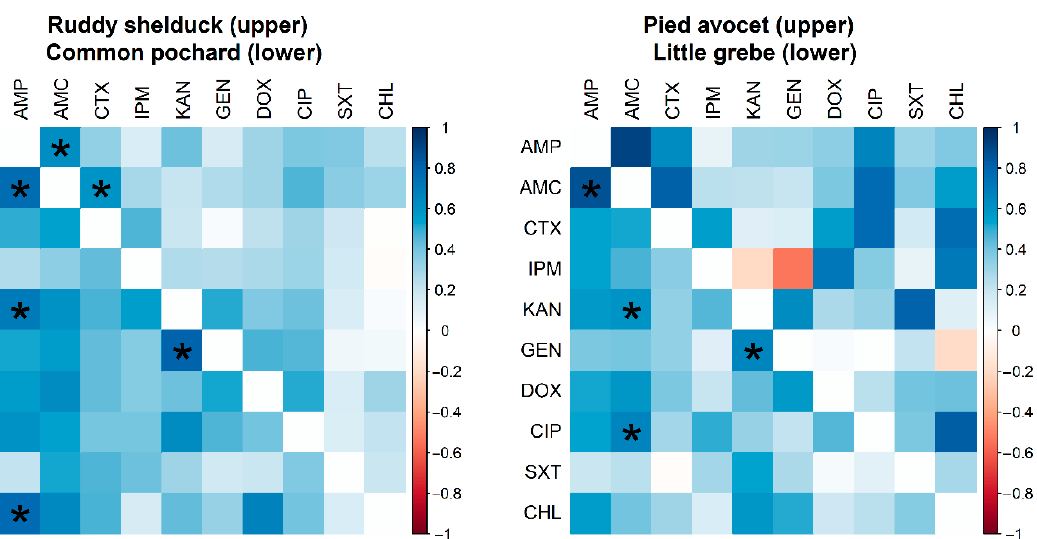
Figure 4. Box and whisker plot of multiple antibiotic resistance (MAR) index among Escherichia coli , Salmonella typhi- murium, and Staphylococcus spp. recovered from different species of migratory wild birds around the Al-Asfar Lake. 2.3. Virulence and Antimicrobial Resistance Genes Of the 90 E. coli isolates, only 9 (10%) and 5 (5.6%) isolates showed the presence of eaeA and stx2 virulence-associated genes, respectively. However, both eaeA and stx2 genes were identified in four (4.4%) isolates. None of the E. coli isolates carried the hlyA and stx1 virulence-associated genes. The frequency of virulence genes in E. coli isolates recovered from each migratory wild bird species is presented in Figure 5.